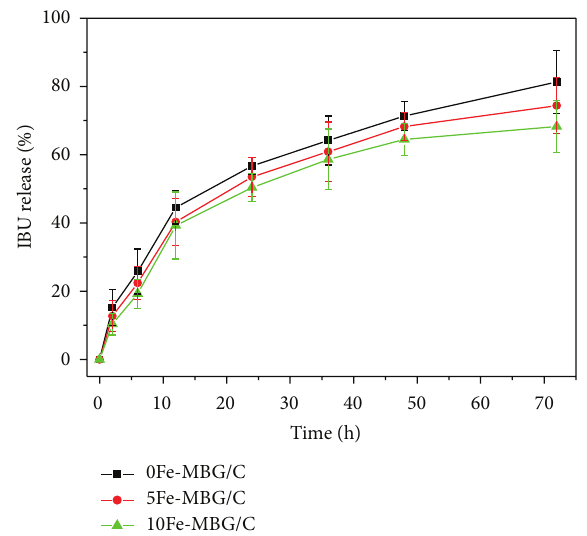
Figure10:IbuprofenreleaseprofilesfromtheFe-MBG/Ccomposite scaffolds with different Fe